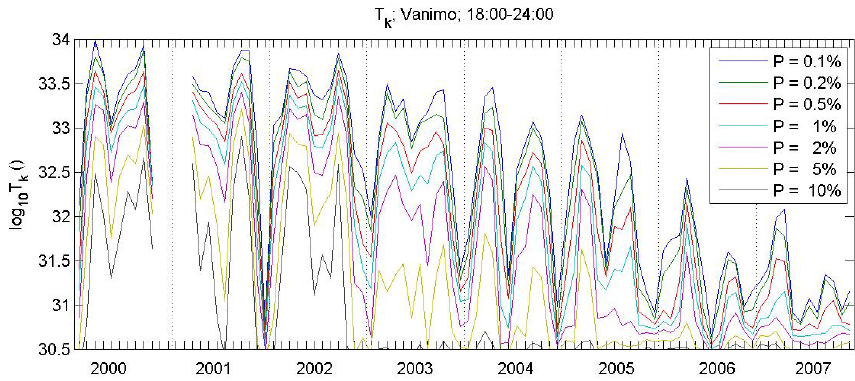
Fig. 5. Values of T k exceeded for various probabilities between 18:00 and 24:00 over Vanimo, for the months of 2000–2007.